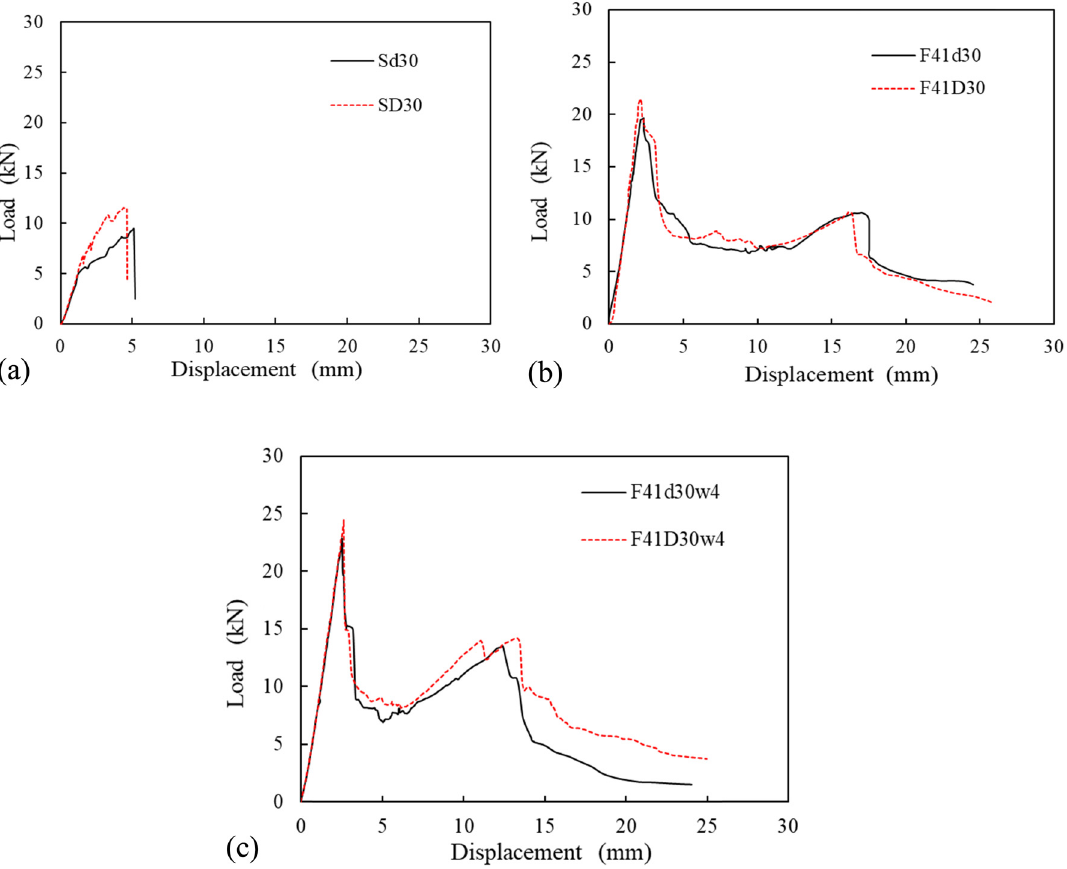
Figure 7: Effect of foam density. ( a ) Bare syntactic foam panels. ( b ) Sandwich specimens. ( c ) Sandwich specimens with lattice